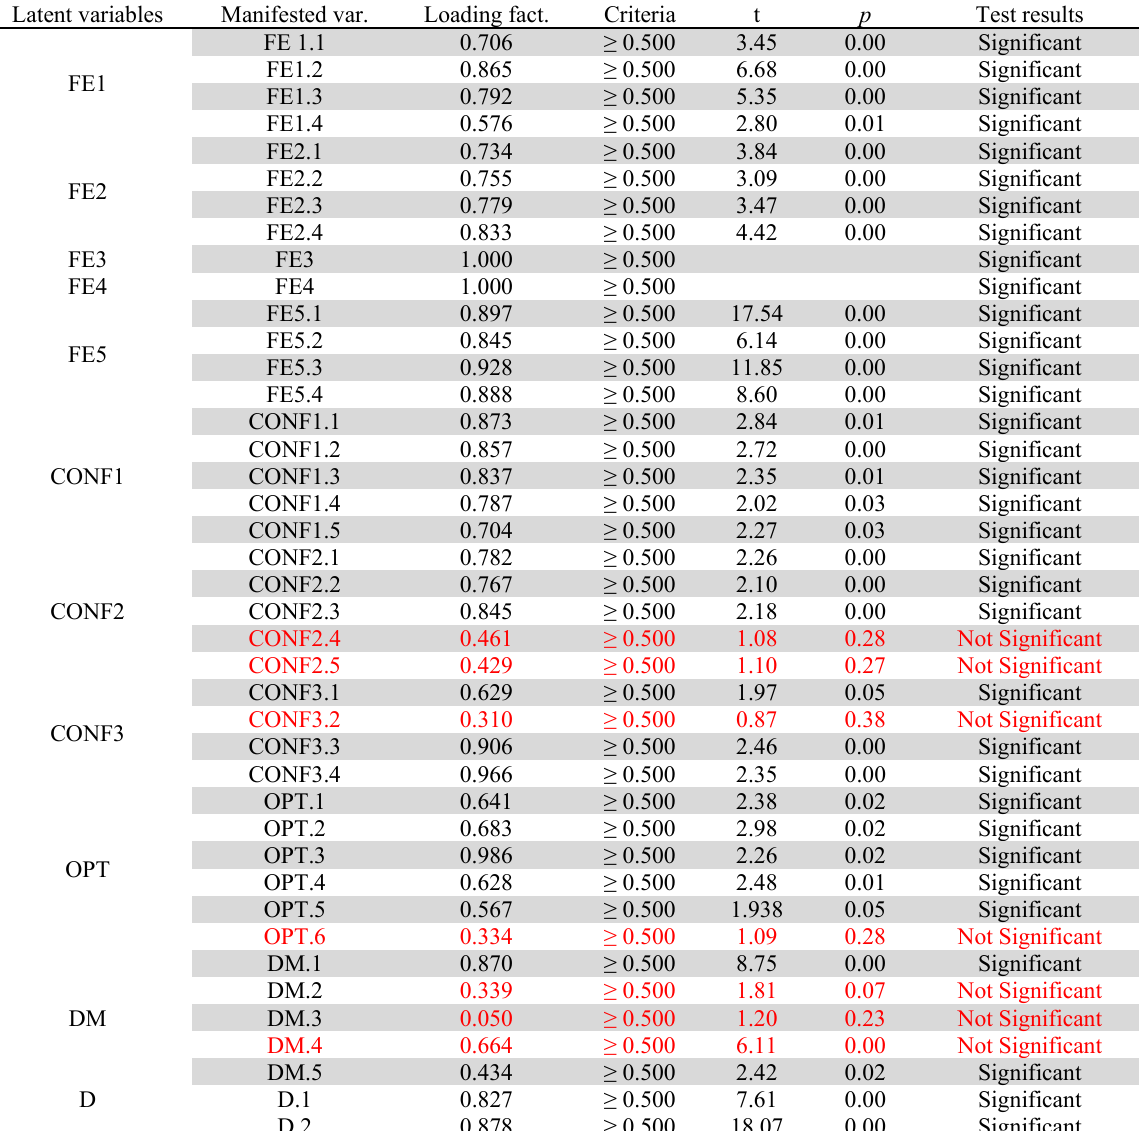
Table A7 Summary of Statistical Analysis (Model IIa) Latent variables